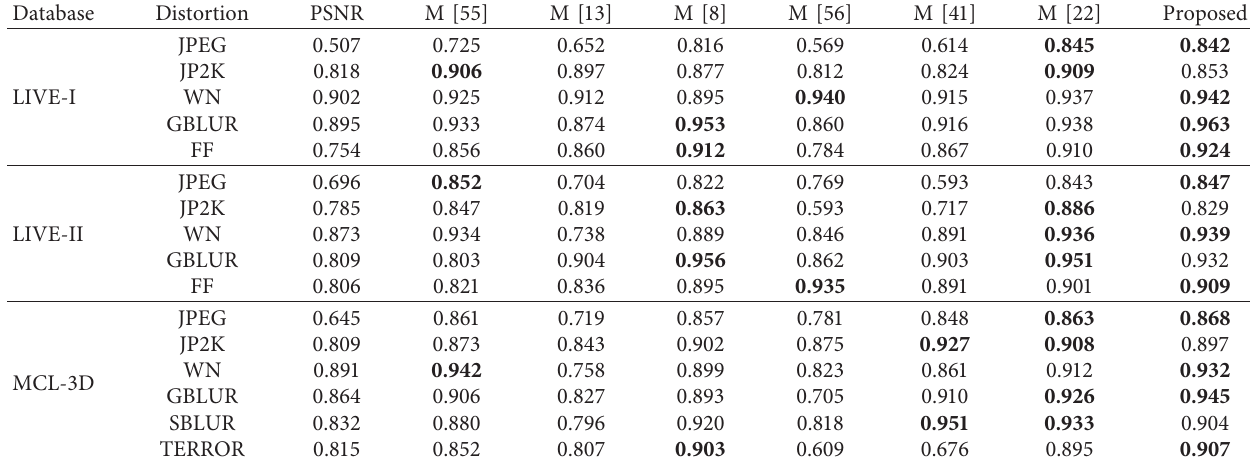
Table 3: SRCC comparison for each type of distortion.